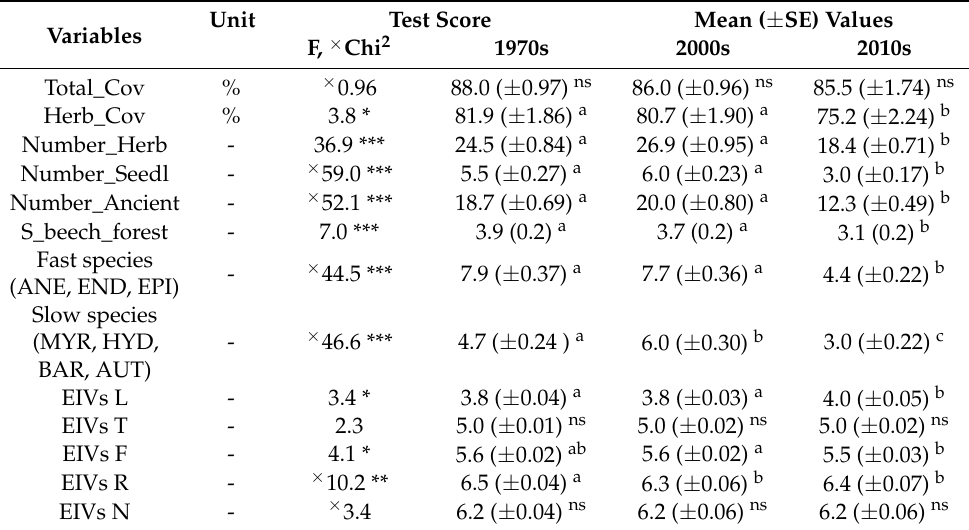
Table 3. Changes in variables obtained based on research at semi-permanent sampling plots over time. Values with different superscript letters differed significantly based on Tukey’s or Wilcoxon’s posteriori tests at the p level, at least p ≤ 0.05. F and Chi 2 —ANOVA and Friedman test score, respectively. Unit Test Variables